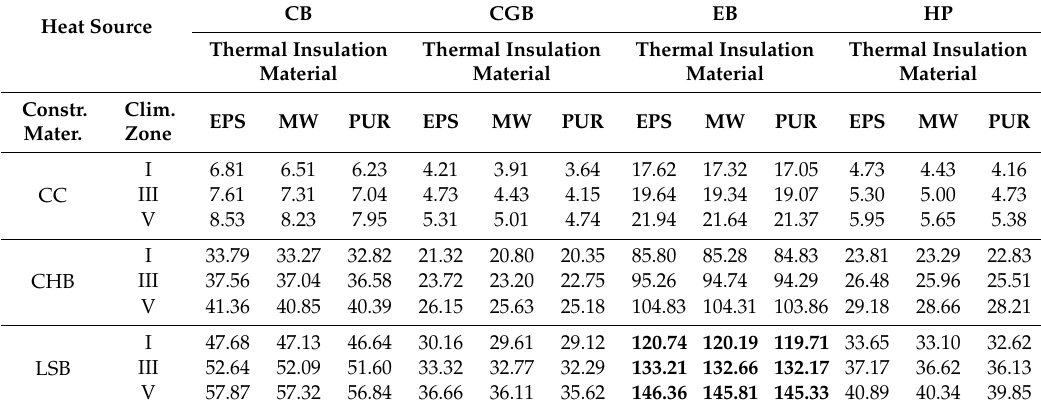
Table 11. NPV E values [Pt / m 2 ] for U = U n